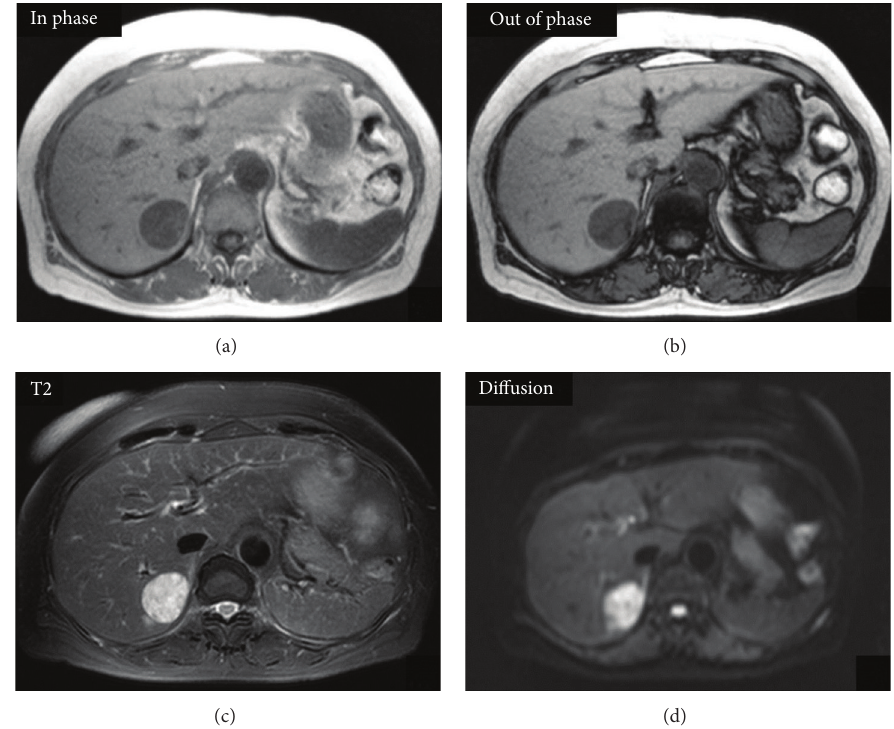
Figure 2: Magnetic resonance imaging. The tumor appeared as a low-intensity area on T1-weighted in-phase (a) and out-of-phase images (b). On T2-weighted with fat saturation and diffusion-weighted images, the tumor appeared as an area of high intensity ((c), (d)).